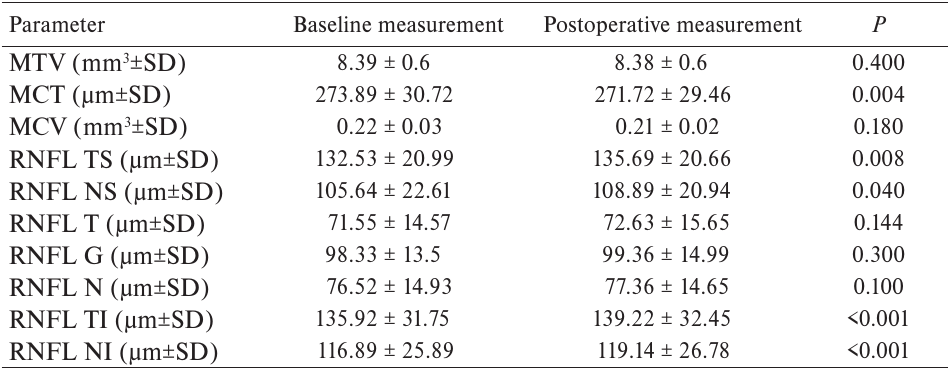
Table 4. Results of repeated OCT measurements.